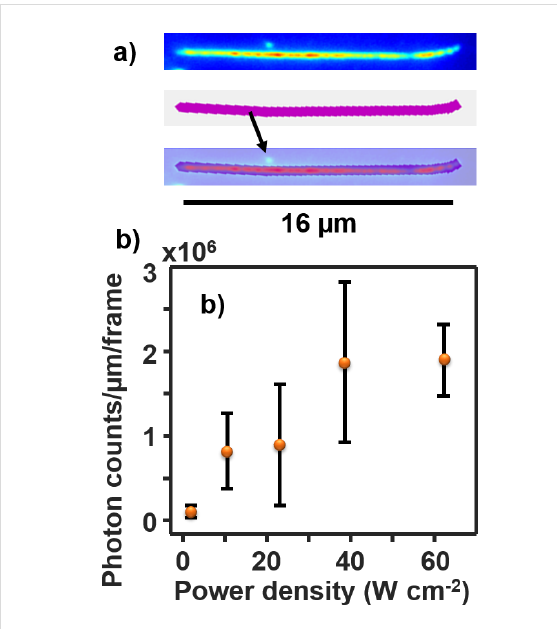
Figure 4: (a) A single DNA molecule (top), the mask used (middle), and overlay (bottom) to select the DNA and filter the other events (the arrow). (b) The intensity (total photocounts) per micrometer of single DNA molecules as a function of laser power density. The images are obtained under TIRF mode but the power densities are measured under epifluorescence mode. YOYO-1 molecules are premixed with λ -DNA at a dye/base pair ratio of 1:10. The error bars represent the standard deviation between at least 25 DNA for two samples.